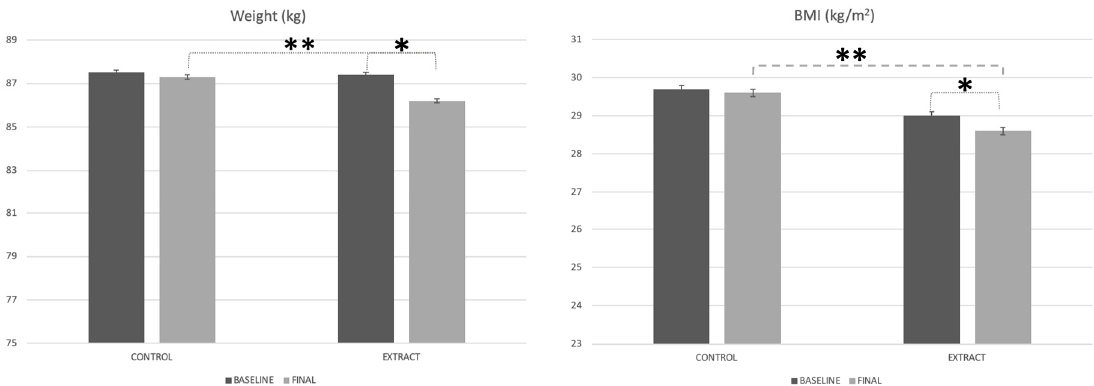
Figure 2. Weight and BMI evolution along the study. *Mean statistically significant differences. ** Mean statistically significant differences between groups.